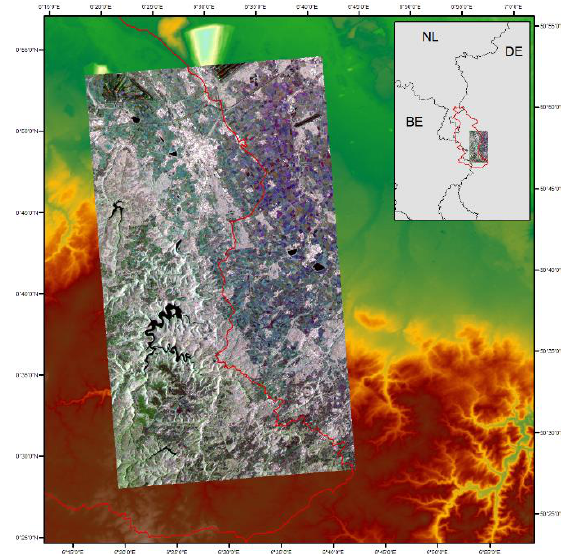
Figure 1. Overview of the study area. Colour-composite of three Sentinel-1 images (see Table 1). Red polygon indicates Rur- Watershed (Background SRTM)